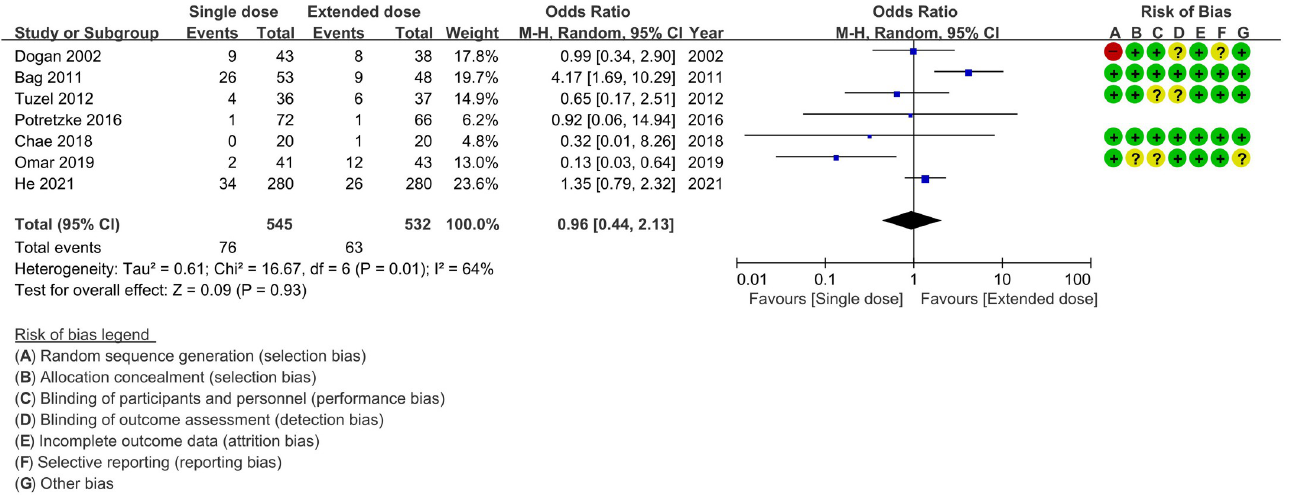
Fig 3. Forest plot. Single dose vs. extended dose in patients with fever.